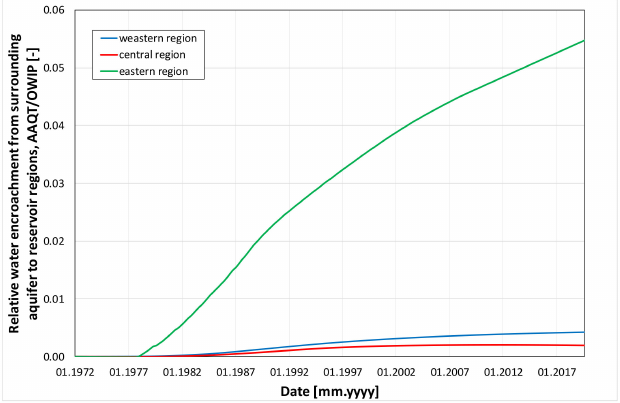
Figure 22. Relative water encroachment from surrounding aquifer to reservoir